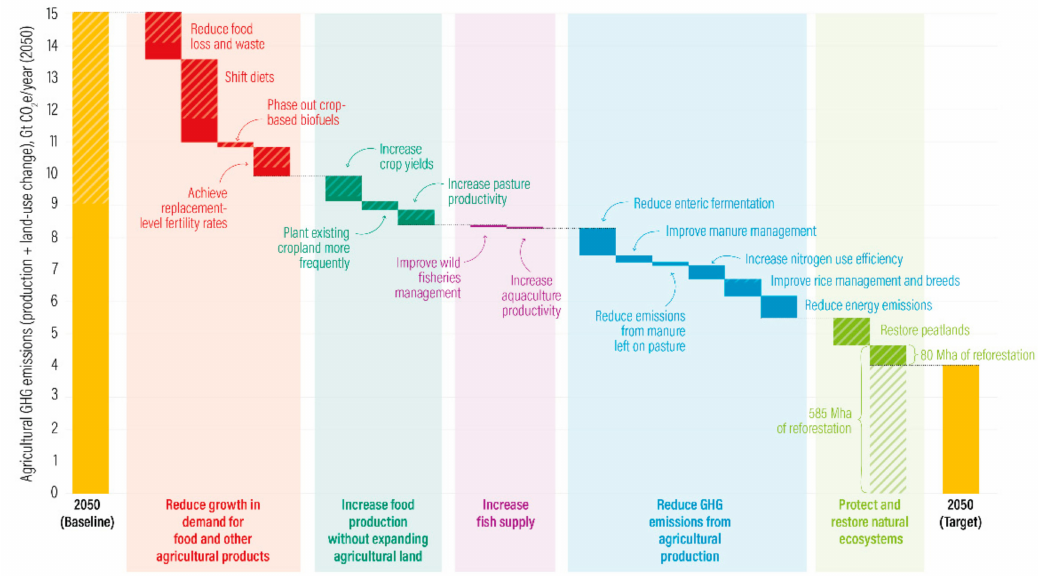
Figure 1. Ambitious e ff orts across all menu items will be necessary to feed 10 billion people while keeping global temperature increases well below 2 degrees Celsius. Originally printed in ([2]). Reprinted with permission from the World Resources